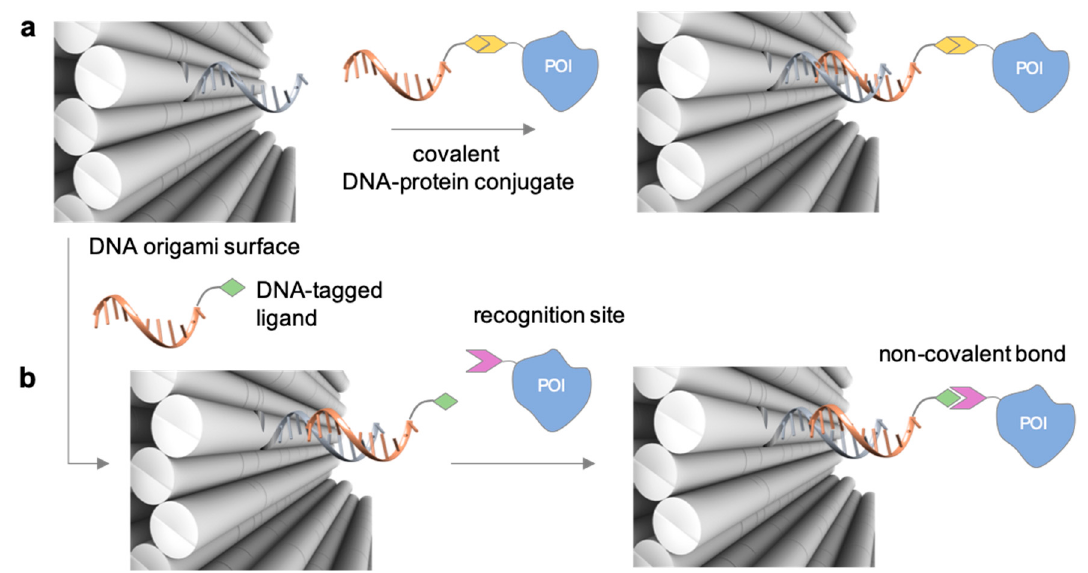
Figure 3. Binding strategies for the attachment of a DNA-protein conjugate to a nanostructured DNA template. The template displays a protruding arm (grey strand) to which the complementary DNA tag of the conjugate (orange strand) hybridizes. In this way, proteins can be organized in space with nanometer resolution either ( a ) through hybridization of a covalent DNA-tagged conjugate or ( b ) through non-covalent binding to a previously hybridized DNA-tagged ligand.